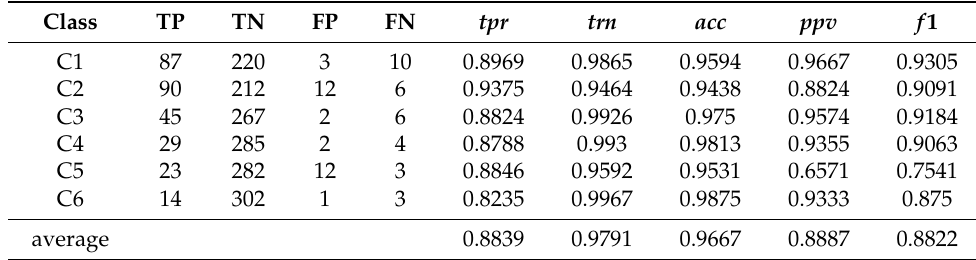
Table 7. Binary confusion matrix for all classes, with